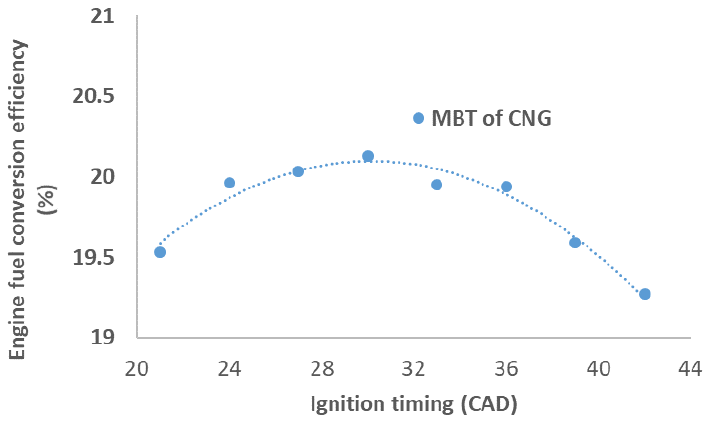
Figure 17. Ignition advance for maximum brake torque (MBT) extracted from Reference [216].